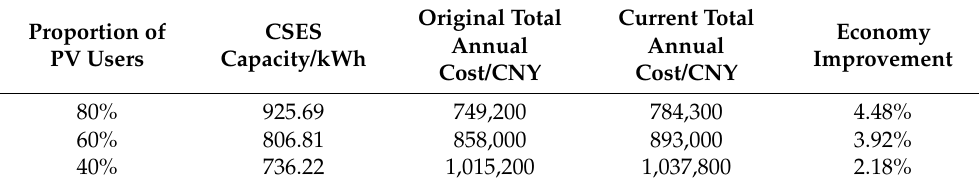
Table 6. Simulation results with different proportions of PV users.